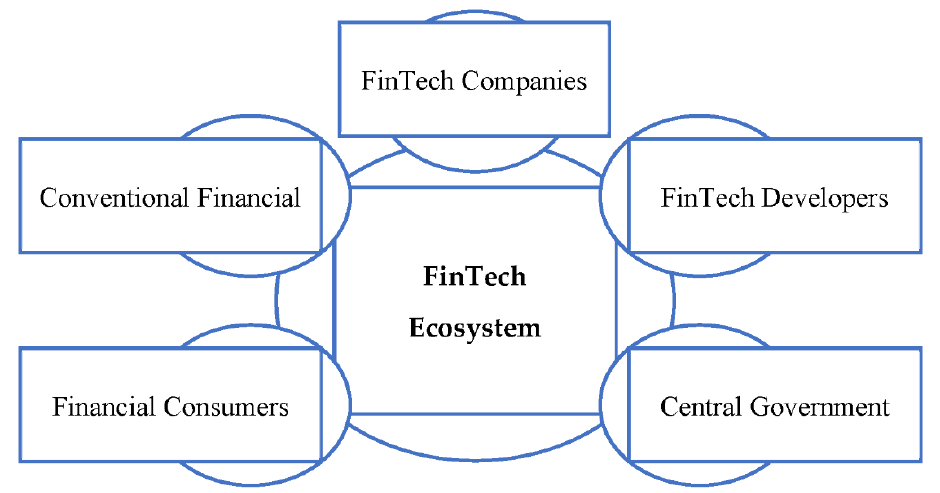
Figure 1. The core contributors in the financial technology ecosystem.